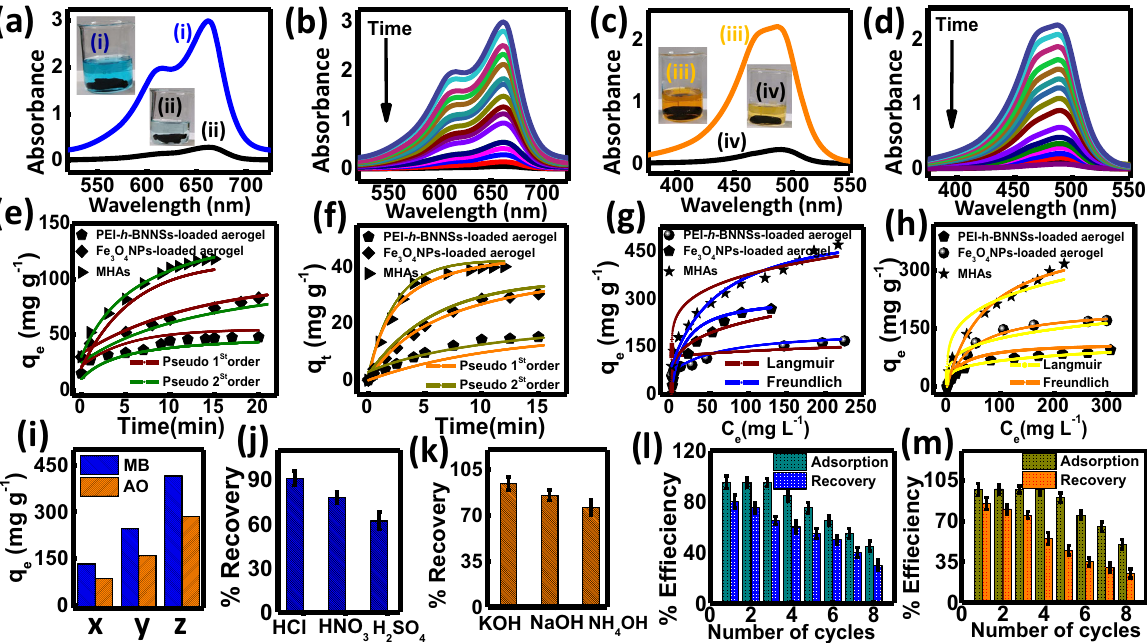
Fig. 7 Modeling studies on organic dyes sorption of isotherm, kinetics and regeneration of adsorbent. Aerogel-mediated removal of MB and AO. Absorption spectra and photographs of ( a ) 50 mg mL − 1 of MB and ( c ) 50 mg mL − 1 of AO (i, iii) before and (ii, iv) after addition of MHA ’ s (2.0 g). Time-dependent absorption spectra of ( b ) 50 mg mL − 1 of MB, and ( d ) 50 mg mL − 1 of AO in the presence of MHAs (2.0 g). Kinetic adsorption curves of PEI- h -BNNSs-loaded PVA aerogels, Fe 3 O 4 NPs-loaded PVA aerogels, and MHA ’ s for ( e ) MB and ( f ) AO. Modeling of adsorption curves with the pseudo- fi rst-order kinetics ( e : brown curve; f : dark orange curve) and pseudo-second-order kinetic ( e : dark green curve; f : dark yellow curve). Adsorption isotherms of the PEI- h -BNNSs-loaded PVA aerogels, Fe 3 O 4 NPs-loaded PVA aerogels, and MHAs for ( g ) MB and ( h ) AO. Adsorption isotherms fi tting of Langmuir model ( g : brown curve; h : bright yellow curve) and Freundlich model ( g : blue curve; h : dark orange curve). (i) The q max values of MB and AO on the surface of (x) PEI- h -BNNSs-loaded PVA aerogels, (y) Fe 3 O 4 NPs-loaded PVA aerogels, and (z) MHAs. j The recovery of MB obtained from multiple washing of MB-adsorbed MHA ’ s with three elution solutions. k The recovery of AO obtained from the washing of MHA ’ s with three elution solutions. l , m The reusability of MHAs for capturing and liberating their (l) MB and (m) AO. e – m The aerogels (2.0 g) were incubated with 10 − 500 mg mL − 1 of MB at pH 8.5 or AO at pH 4.5 for ( e ) 0 − 20 min and ( f – m ) 0 – 15 min at 298